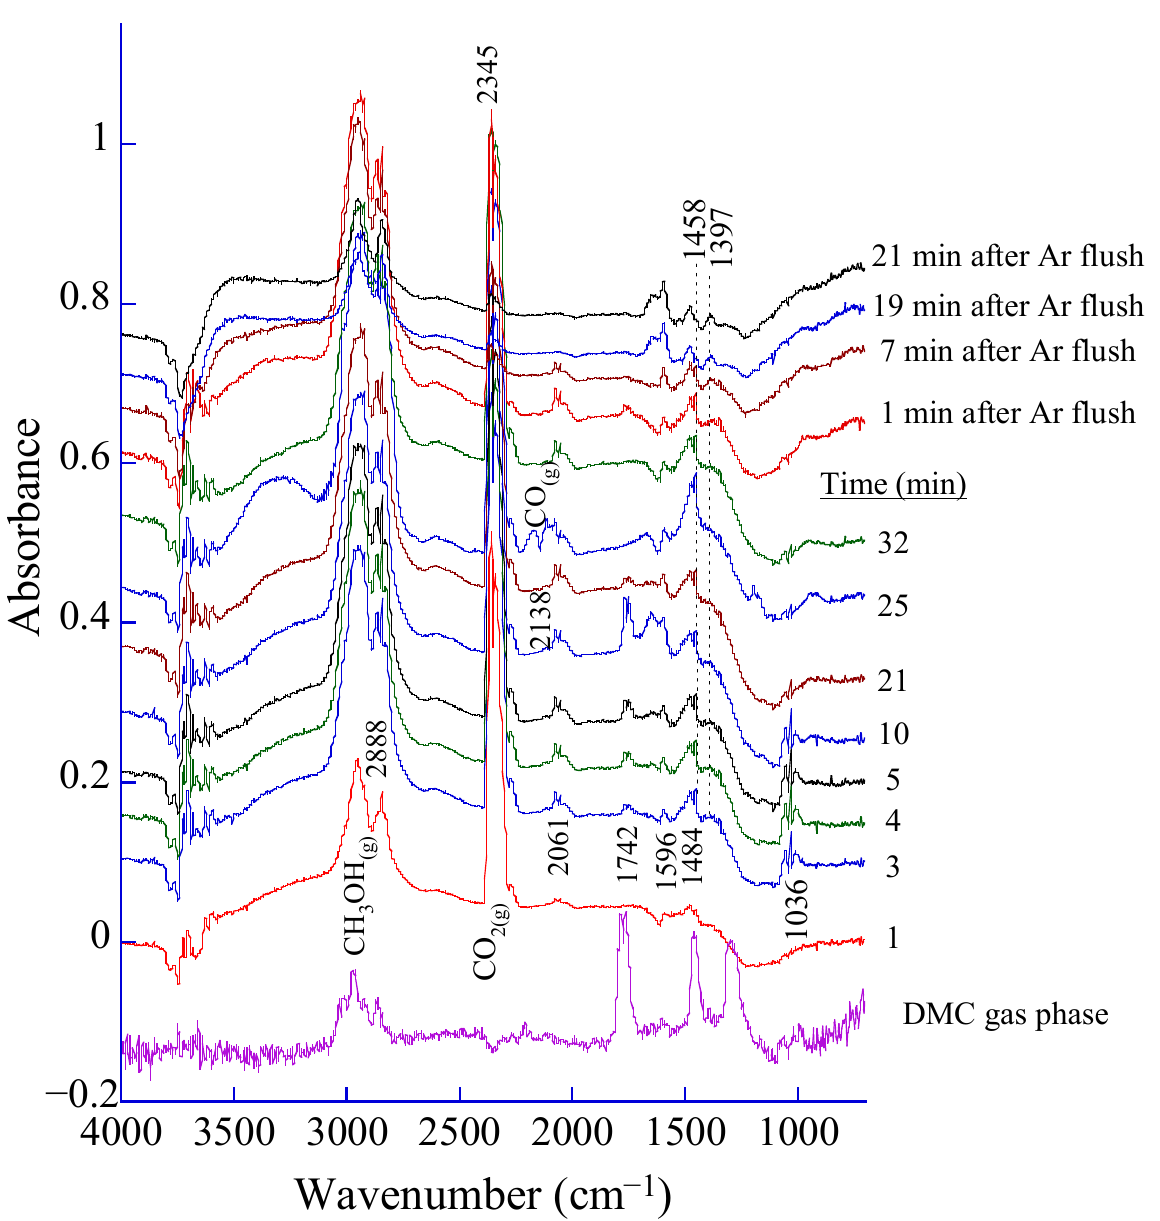
Figure 9- IR spectra during the methanol-CO 2 reaction over 5% Rh/Al 2 O 3 at 393 K. Figure 9. IR spectra during the methanol-CO 2 reaction over 5% Rh/Al 2 O 3 at 393